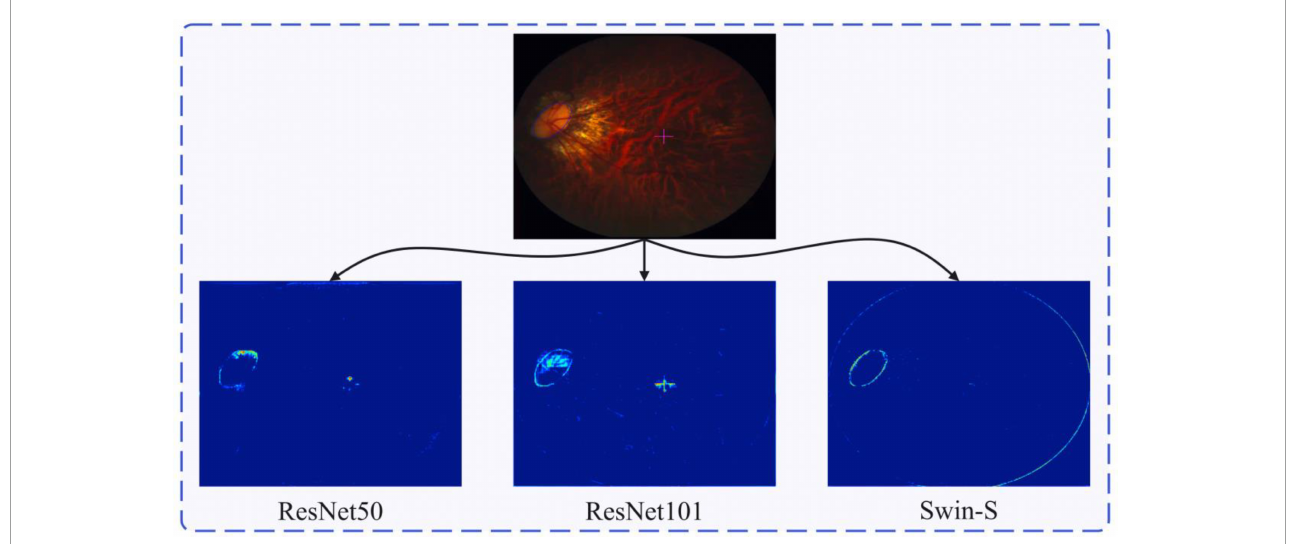
FIGURE6 Retinal fundus image and the corresponding feature heatmap generated by different backbones, the heatmap of the feature learned by ResNet50, ResNet101, and Swin-S from left to right.